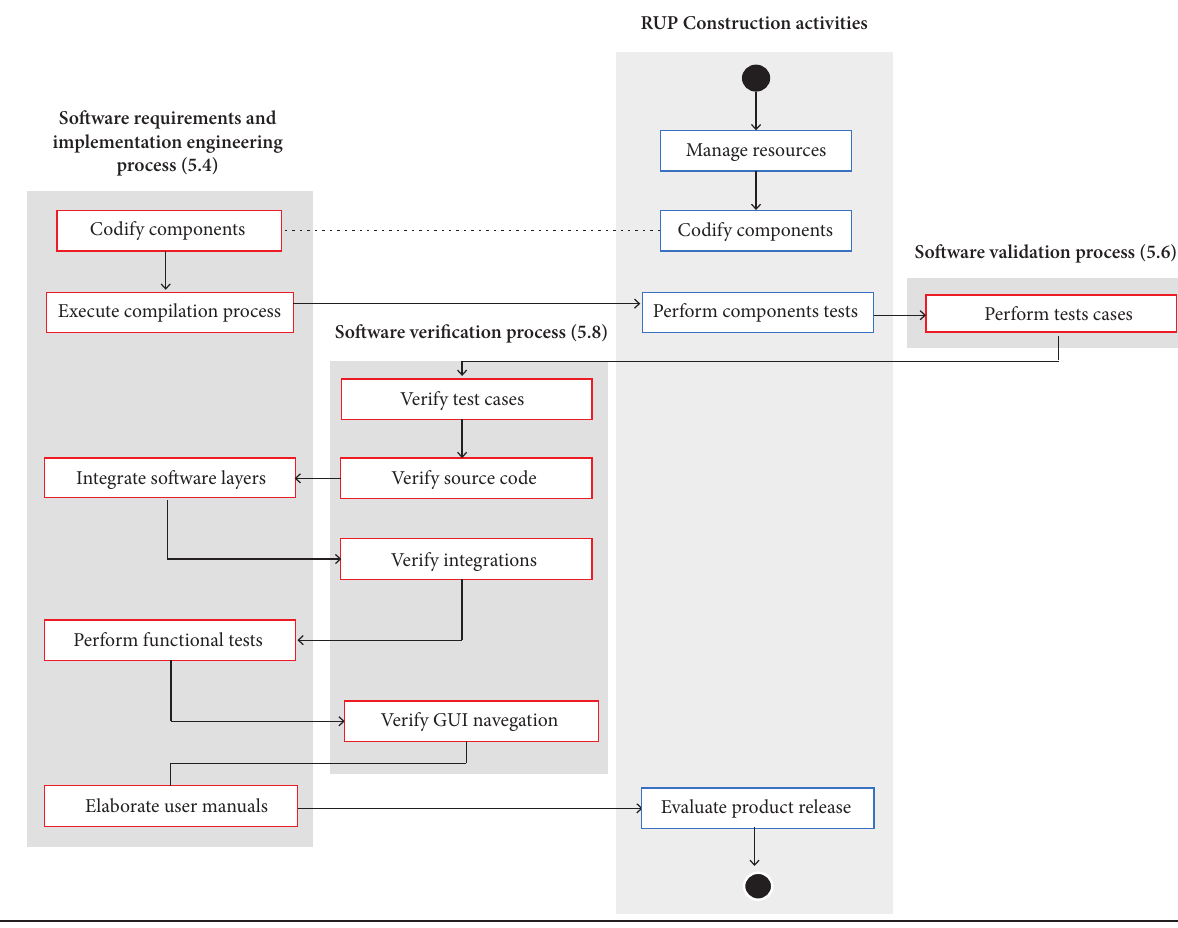
figure 9. Construction phase activities for the